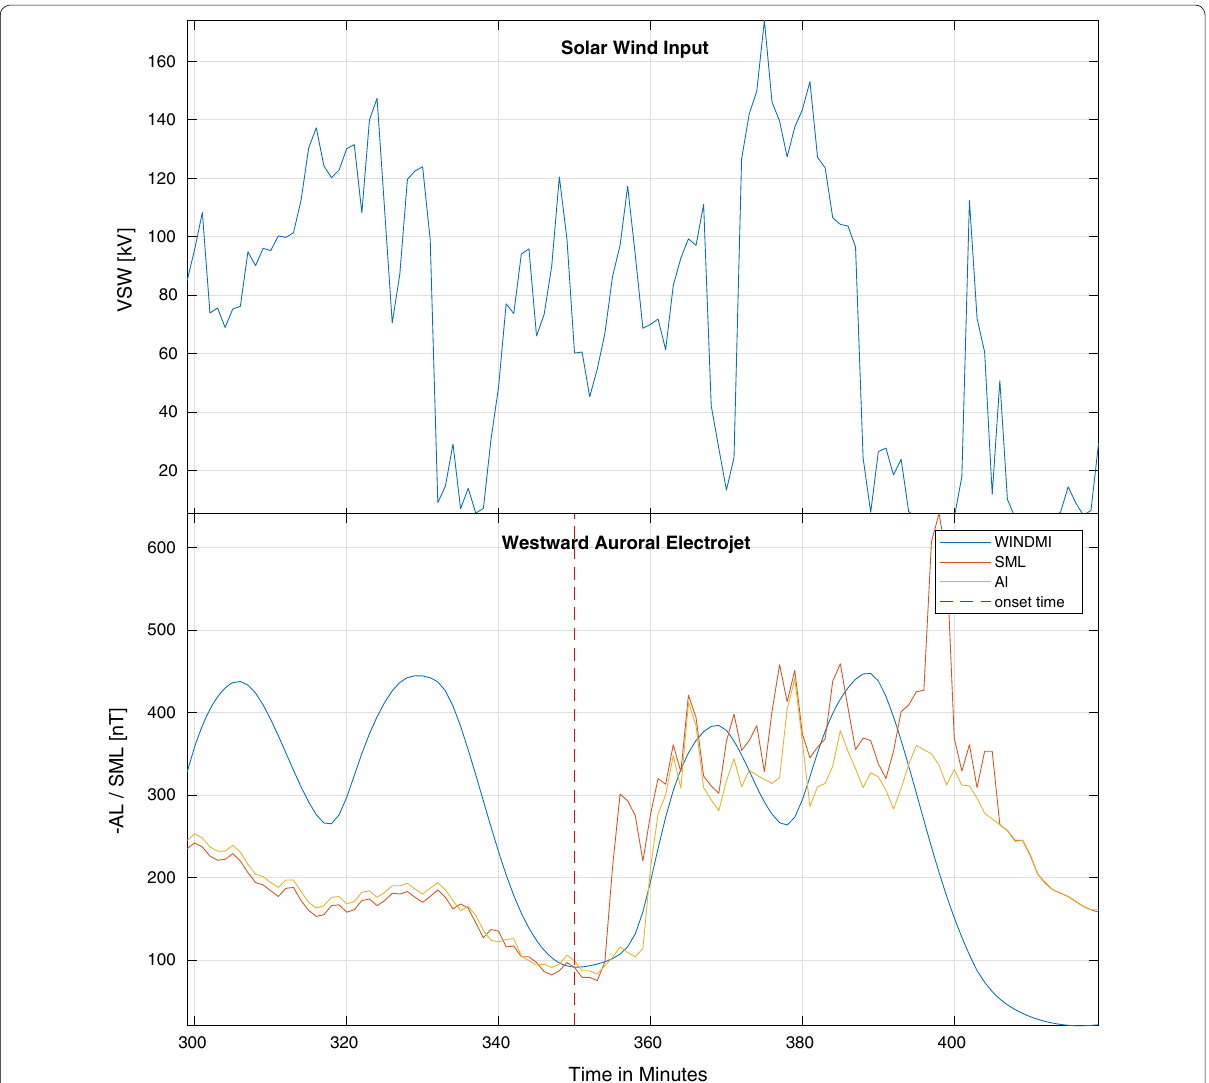
Fig. 3 Event 05:50 UT 07 March 2007: In the bottom panel, substorm onset time from auroral observations is depicted with the red-dotted line. The WINDMI model output is compared to the AL and SML indices. The top panel shows the solar wind input measured by the ACE satellite and propagated to the nose of the